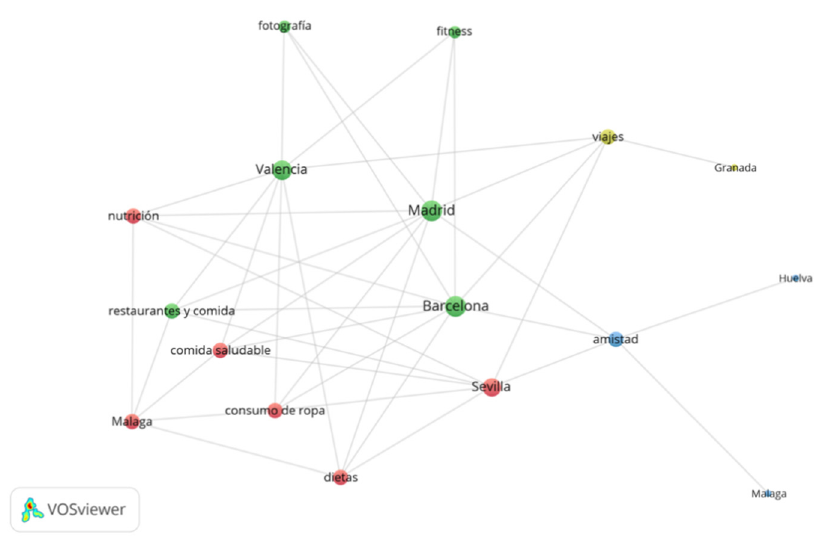
Figure 6. Network of relations between topics and cities.